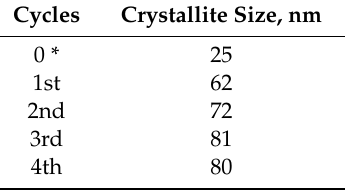
Table 2. Evolution of Ni crystallite size of the catalyst regenerated in five consecutive reaction- regeneration cycles.